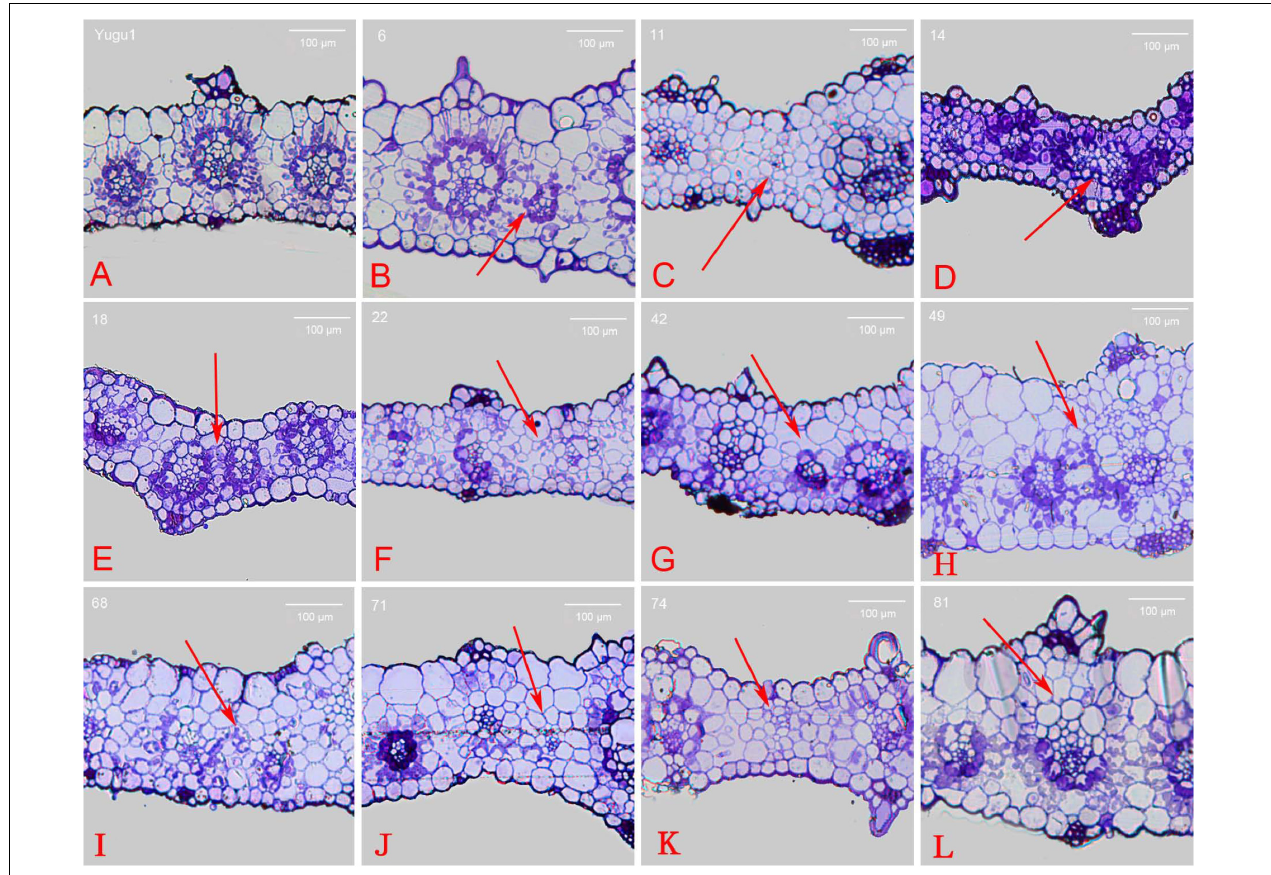
FIGURE 4 | Cross section of wild-type and mutant leaves embedded in resin. (A) wild-type Yugu1; (B) t6 ; (C) t11 ; (D) t14 ; (E) t18 ; (F) t22 ; (G) t42 ; (H) t49 ; (I) t68 ; (J) t71 ; (K) t74 ; and (L) t81 . Scale: 100 µ m. The red arrows indicated the altered part in the leaf tissue cross